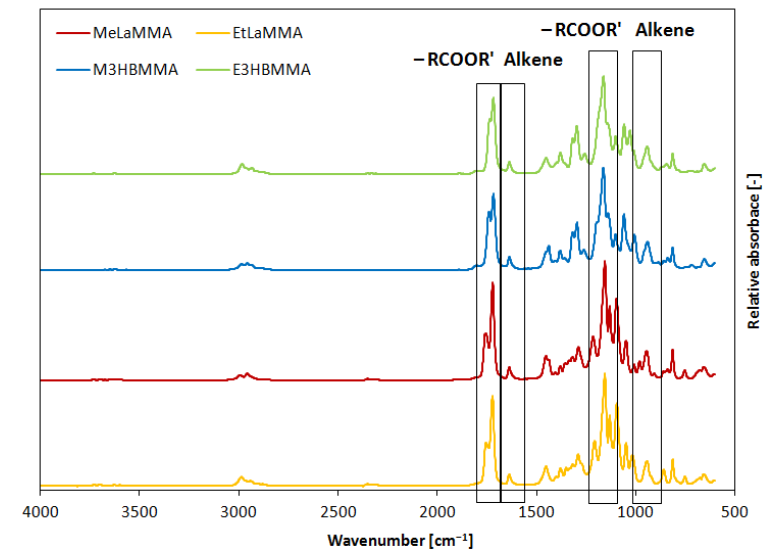
Figure 8. FT-IR spectra of the synthesized methacryled alkyl esters as products of the methacrylation reaction of alkyl esters of lactic acid or 3-hydroxybutanoic acid and methacrylic anhydride.